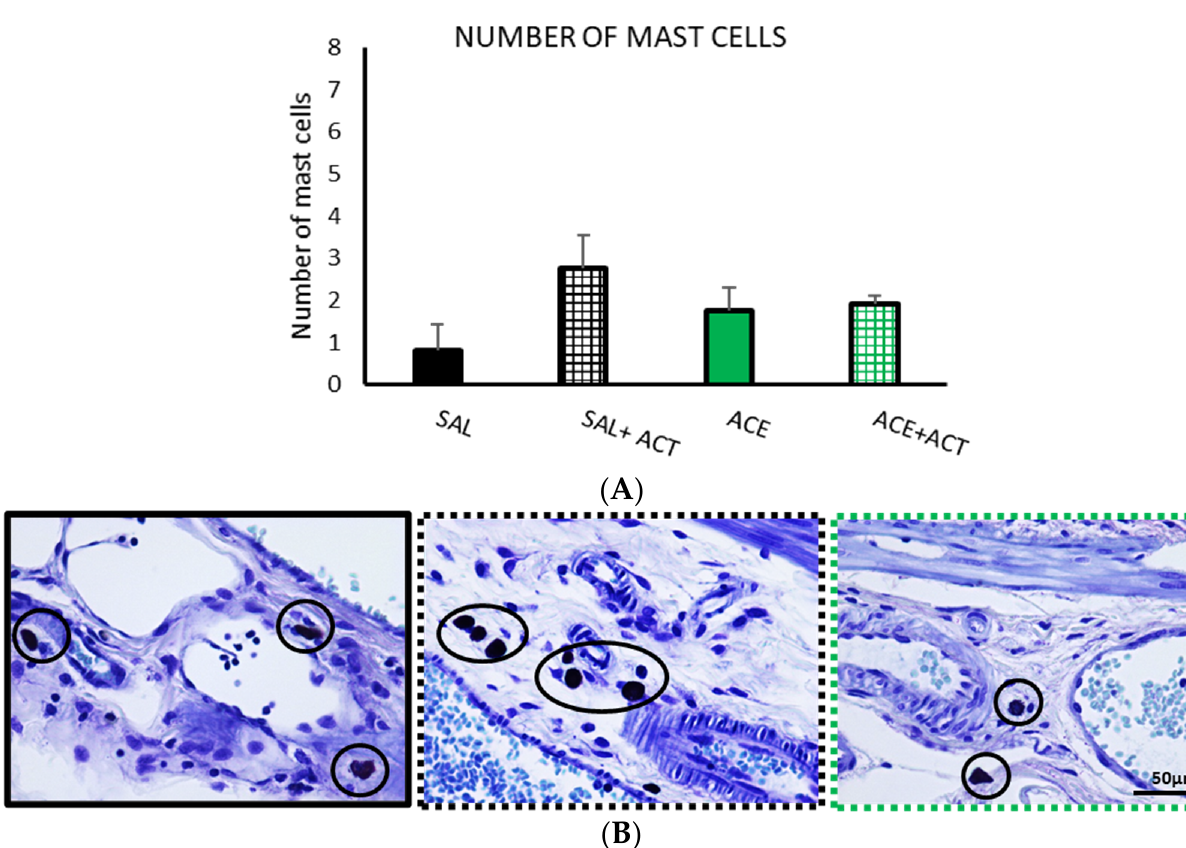
Figure 9. Effects of pretreatment with probiotics on the number of mast cells, phase II. The groups selected in phase I (SAL30 and ACE 0.6% 30, now termed SAL, black bar and ACE, green bar) were compared with the corresponding two groups that were pretreated with 1 mL/day of Actimel ® (ACT) (SAL + ACT black gridded bar, ACE + ACT green gridded bar). ( A ) The number of mast cells was counted in ten random fields per section across mucosa and submucosa. Data represent mean ± SEM. One-way ANOVA followed by Bonferroni post hoc test ( n = 8–13). ( B ) Photomicrographs of colonic samples stained with toluidine blue for mast cell detection (circles) after intracolonic administration of SAL (black frame) or in animals pretreated with Actimel ® after intracolonic administration of saline (SAL + ACT; black dotted frame) or 0.6% acetic acid (ACE + ACT; green dotted frame). Scale bar = 50 μm .